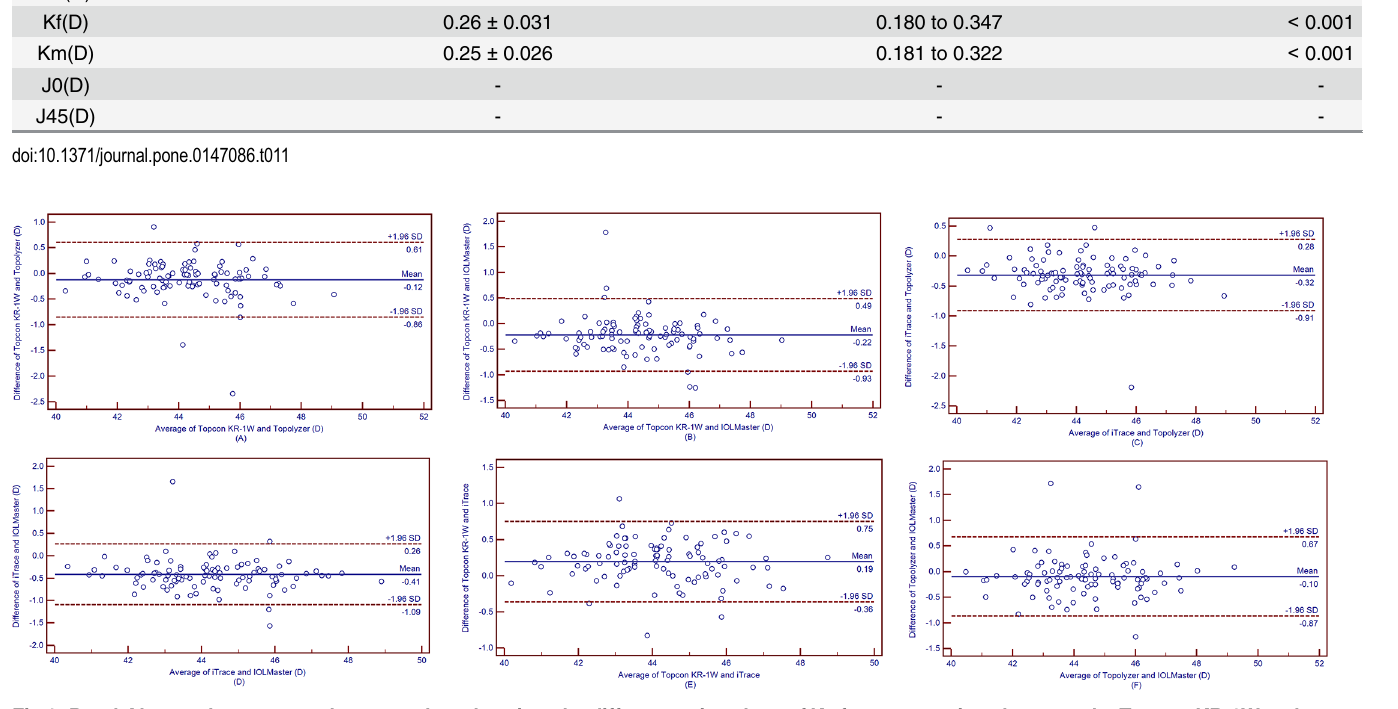
Fig 1. Band-Altman plots present the mean plotted against the differences in values of Ks for a comparison between the Topcon KR-1W and Topolyzer (A), Topcon KR-1W and IOLMaster (B), iTrace and Topolyzer (C), iTrace and IOLMaster (D), Topcon KR-1W and iTrace (E), Topolyzer and IOLMaster (F). The solid line indicates the mean difference. The interval between upper and lower lines represent the 95% LoA.